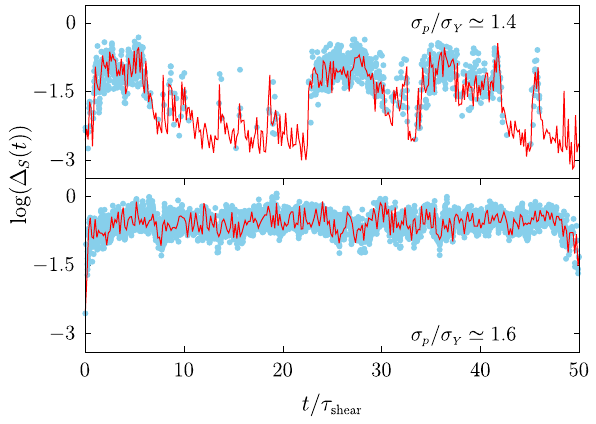
Þ , while dots single out s ¼ S − 1 as derived from shear